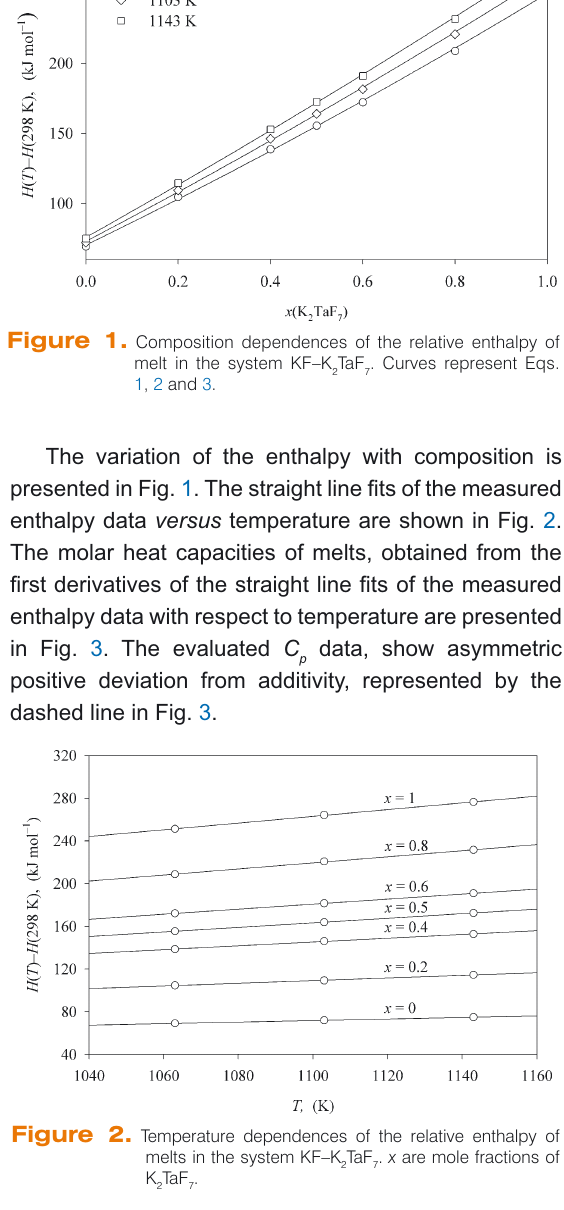
melts in the system KF–K K TaF 2 7